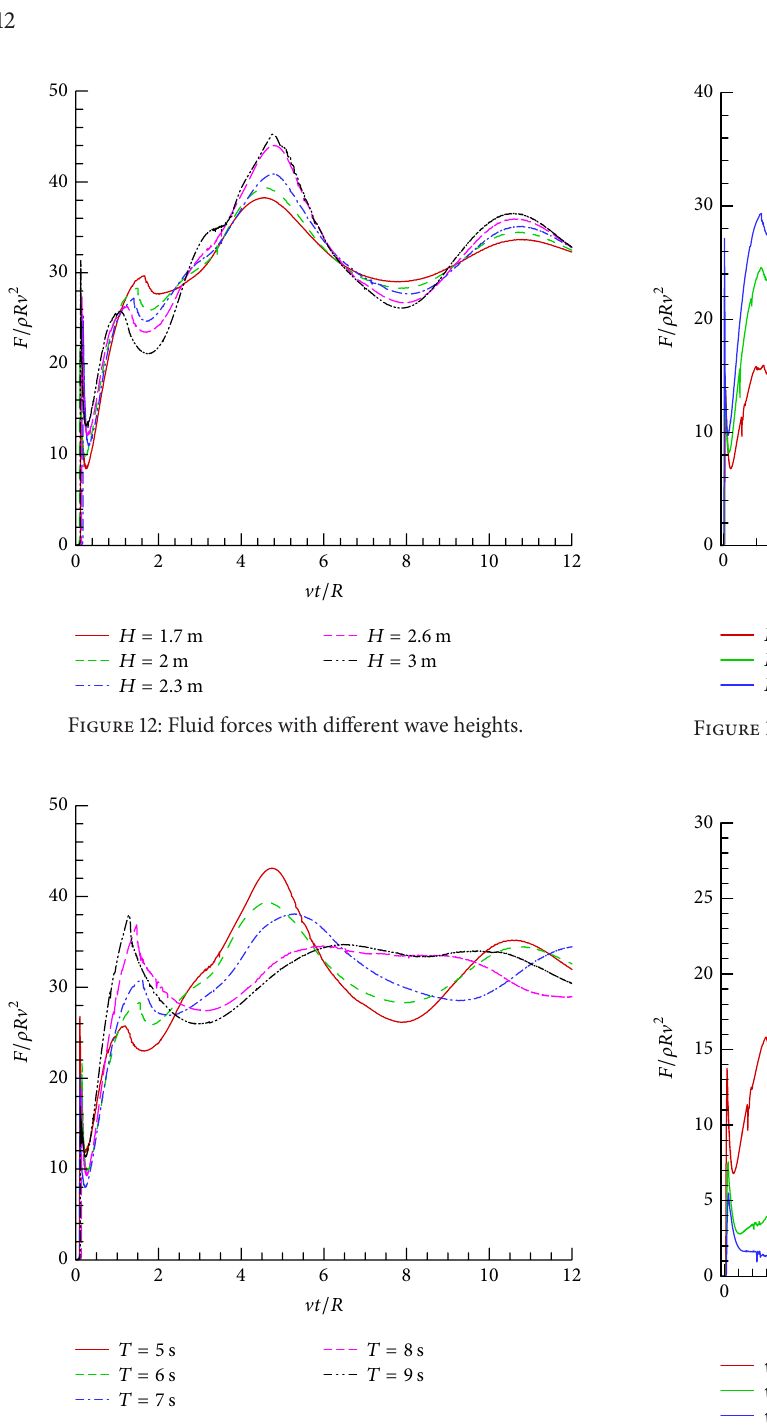
Figure 13: Fluid forces with different wave periods.